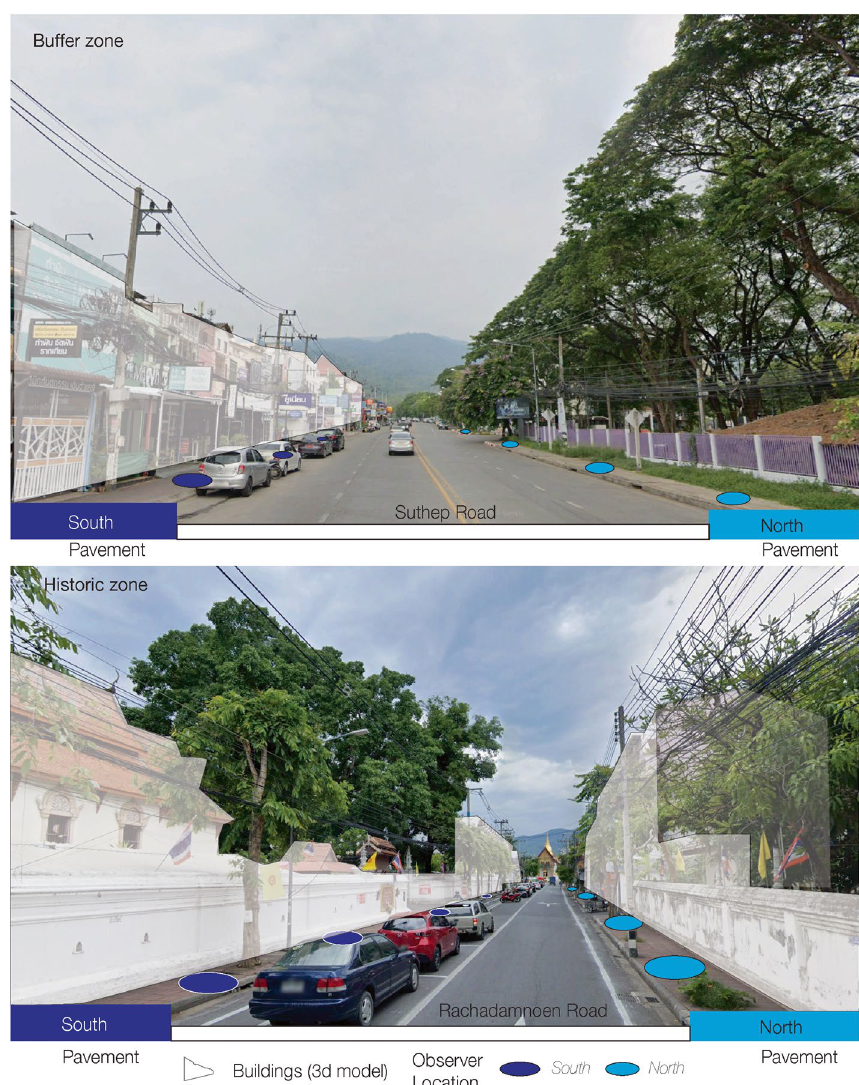
Fig. 2 View from Rachadamnoen and Suthep road to Doi Suthep Mountain (Source: the